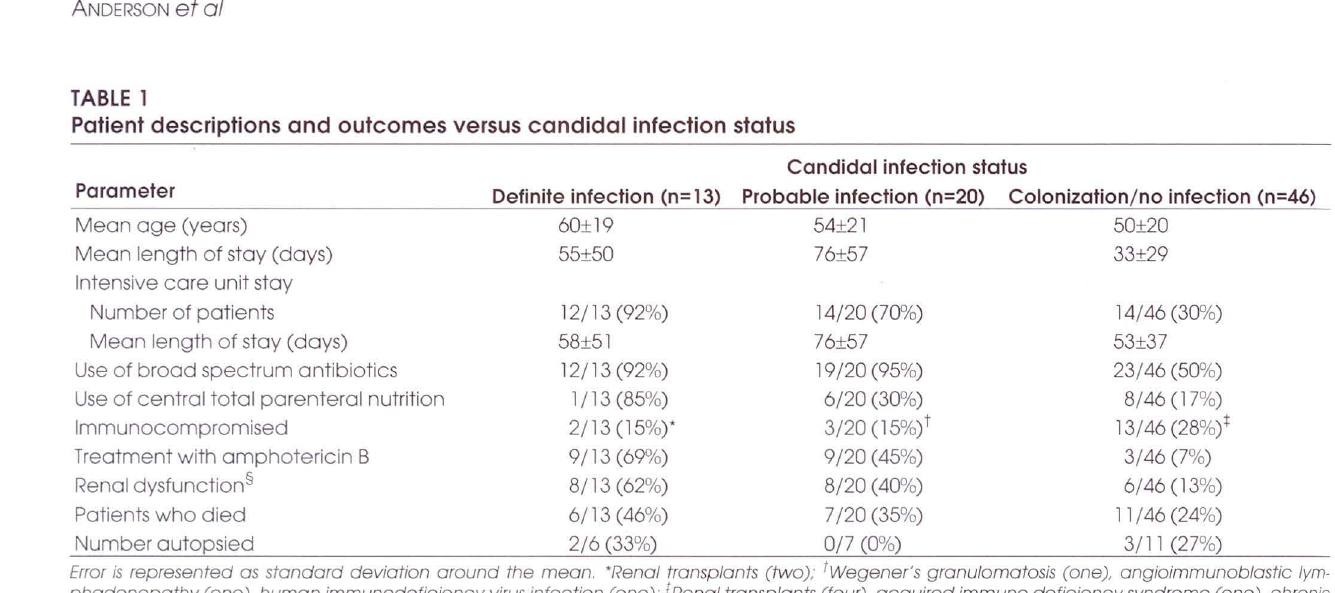
Characteristics of Cand-Tee testing versus candida! infection status Cand-Tee testing profile Definite infection